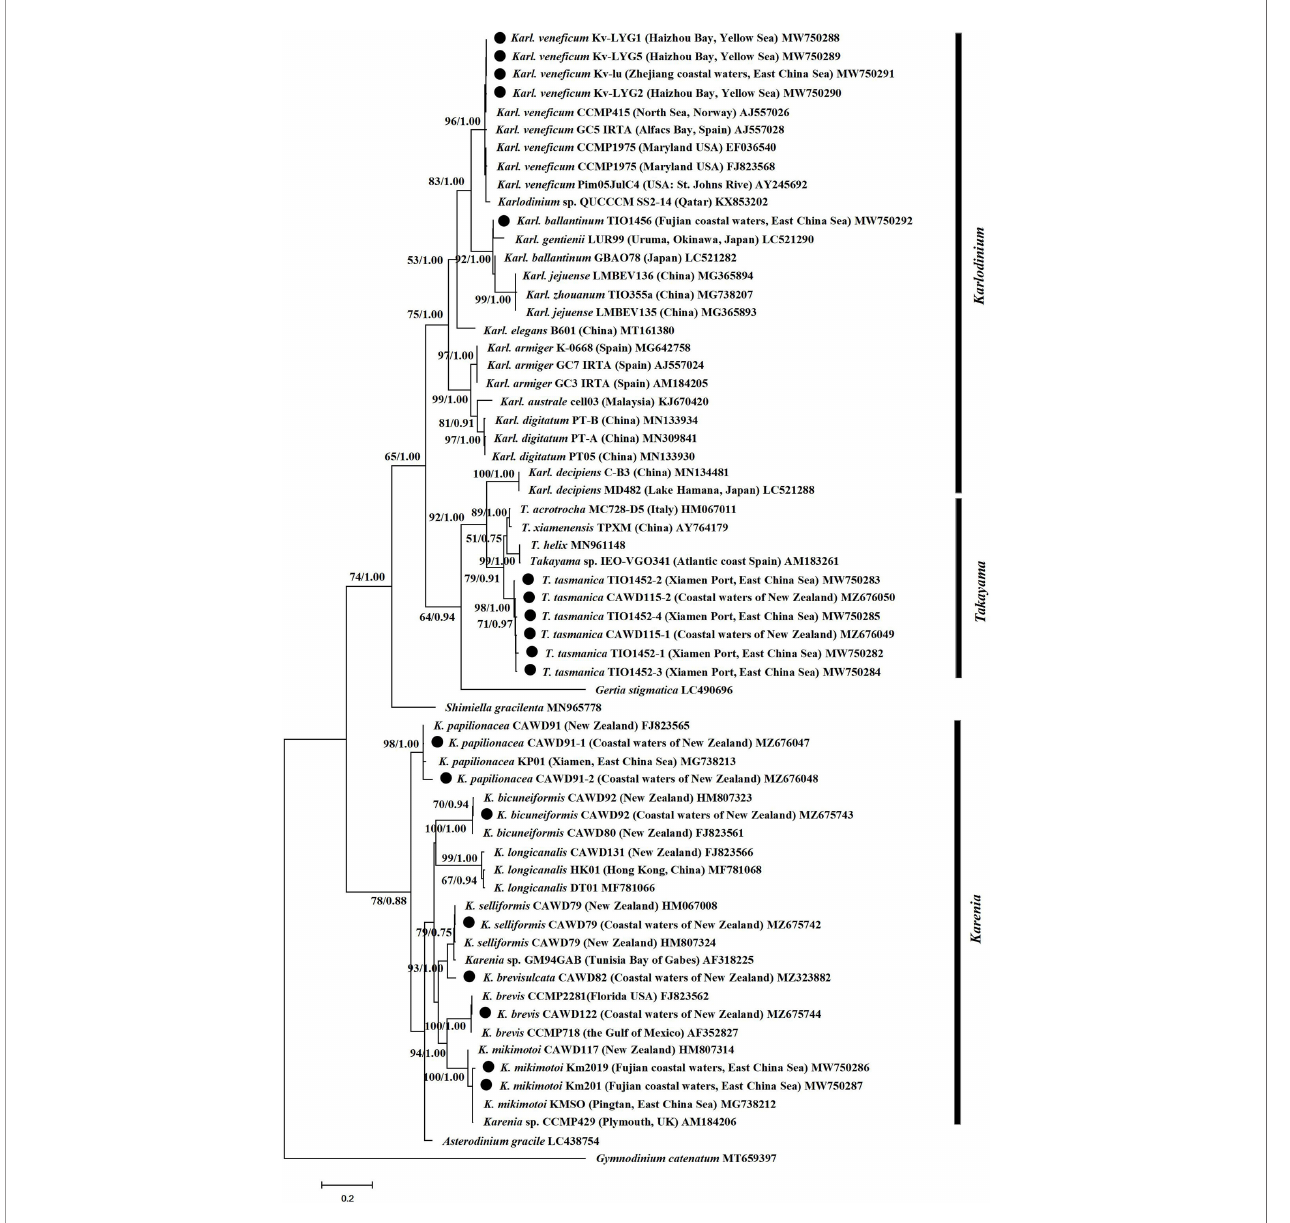
FIGURE 2 | Phylogenetic tree of Kareniaceae species based on ITS sequences. Sequences with a circle were obtained in this study. Values at nodes suggests statistical support values (ML bootstrap values/Bayesian posterior probability). Only bootstrap values >50% and posterior probabilities >0.5 are